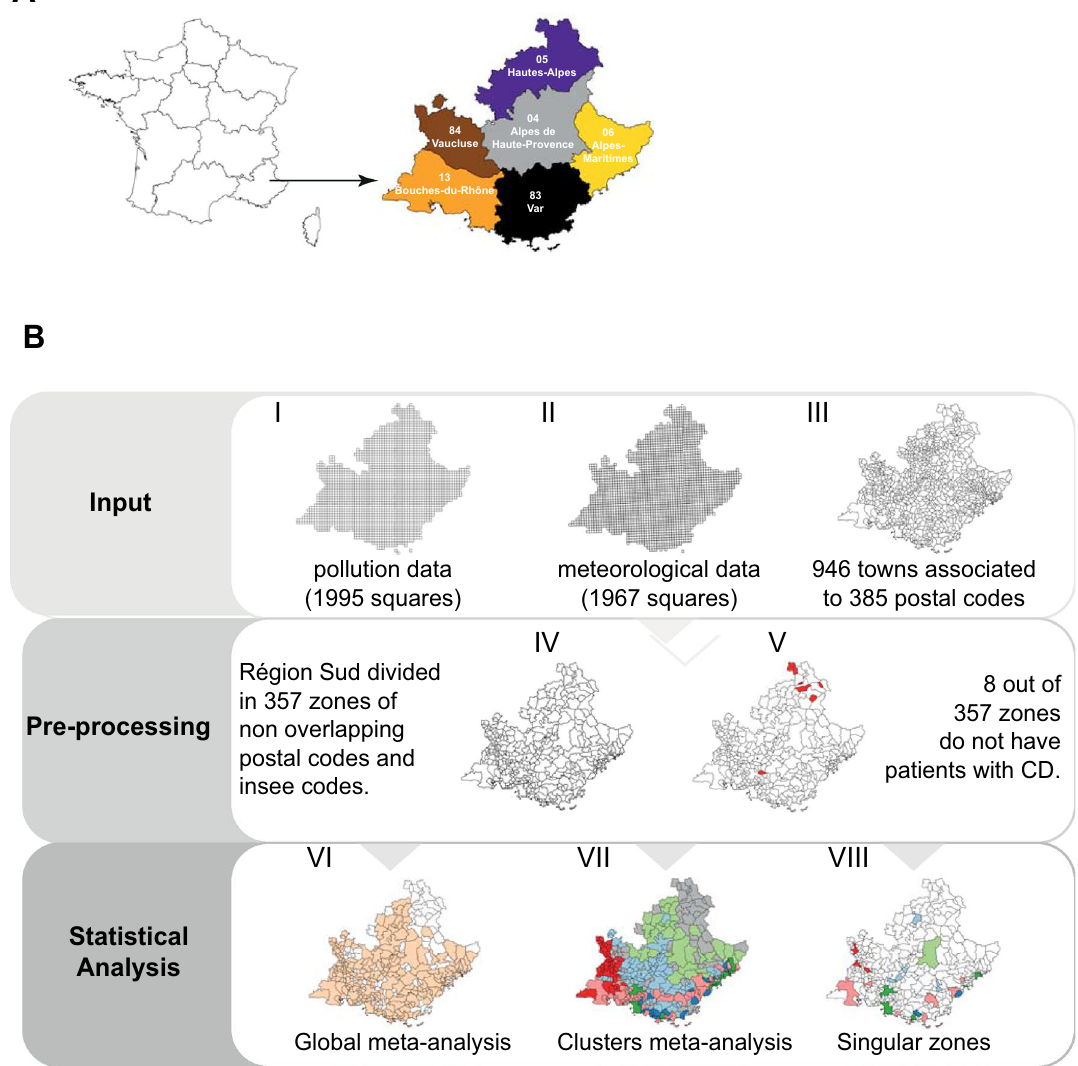
Figure 1. Study design and data analysis workflow. (A) The Région Sud and its 6 departments. The three databases used had different resolutions: non-overlapping meshes of 4 km squares for pollution (B I) and meteorological variables (B II) , and postal codes for emergency room visits data (B III) . To reconciliate the databases, we created 357 zones (B IV) of non-overlapping postal codes. 8 zones, for which no CD events were registered during the period under study, were filtered out, for a total of 349 zones (B V) . Finally, the model was run globally on 251 zones out of 349 because 97 zones contain less than 18 CD events (minimal empirical value of employability of the model) over the entire period of 6 years concerned by this study (B VI) . Then the model was run on zones grouped by pollution trends (B VII) . Finally, the model was run on the 251 zones singularly and 23 zones with the highest number of CD events were selected (B VIII) . Maps were created with the R package maptools v1.1-1.